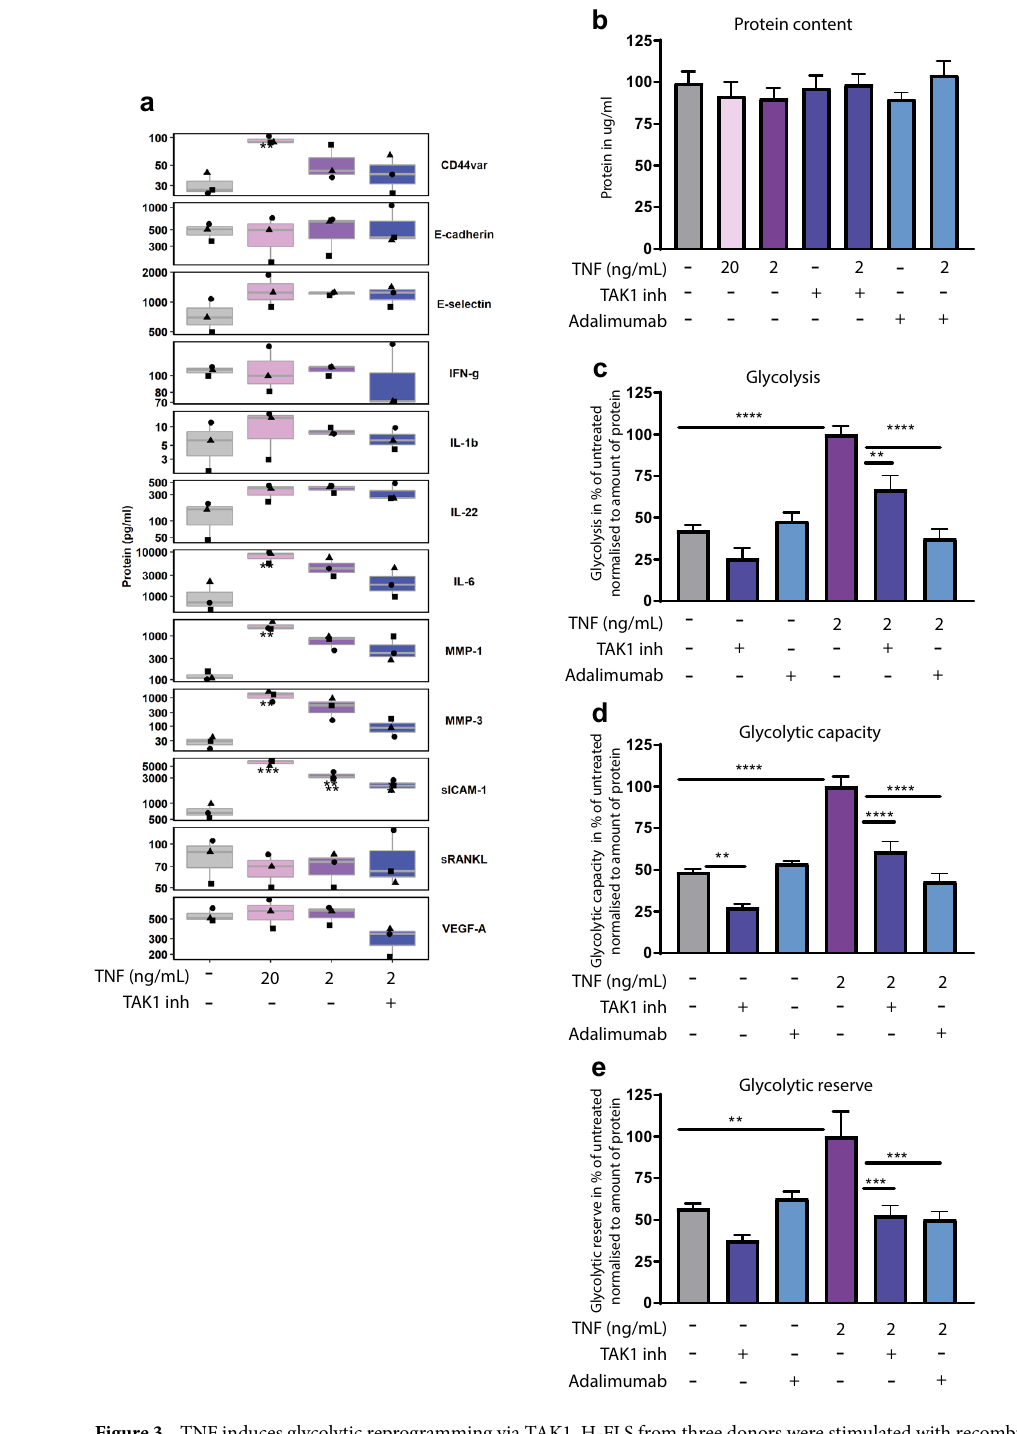
Figure 3. TNF induces glycolytic reprogramming via TAK1. H-FLS from three donors were stimulated with recombinant human TNF, TAK1 inhibitor (5Z)-7-Oxozeaenol (0.5 µM) or the anti-TNF antibody Adalimumab (50 nM) at indicated concentrations for 24 h. ( a ) Luminex® Multiplex assay to evaluate cytokines and disease-relevant biomarkers in cell culture supernatants (3 donors, 1 experiment). One dot represents one donor, donors can be differentiated based on the shape. Significance to unstimulated are highlighted. ( b ) Protein content was analyzed using BCA assay 24 h after stimulation (experiments performed with 6 technical replicates, 1–2 independent experiments, 3 different donors). ( c – e ) Real-time analysis of the glycolytic function of FLS using Seahorse XFe96. Glycolysis stress test with injection of glucose (24 mM), oligomycin (1 µM) and 2-DG (100 mM). ( c ) Glycolysis ( d ) Glycolytic capacity ( e ) Glycolytic reserve. Data were normalized to protein content using BCA assay (experiments performed with 6 technical replicates, 1–2 independent experiments, 3 different donors). Values represent means ± SEM (b-e) or are depicted as boxplot with median and first and third quartile (a). *P ≤ 0.05; **P ˂ 0.01; ***P ˂ 0.001; ****P ≤ 0.0001, one-way ANOVA with Tukey multiple pairwise-comparisons test (a), unpaired one-way Anova with Dunnett correction ( b – e